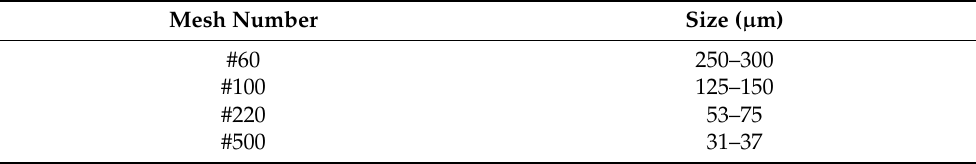
Figure 6. Diagrams of the working part by WEDM: ( A ) A cross-section specimen; ( B ) dimensions of the workpiece. Table 1. The mesh number vs. size of abrasive particles of the silicone carbon.